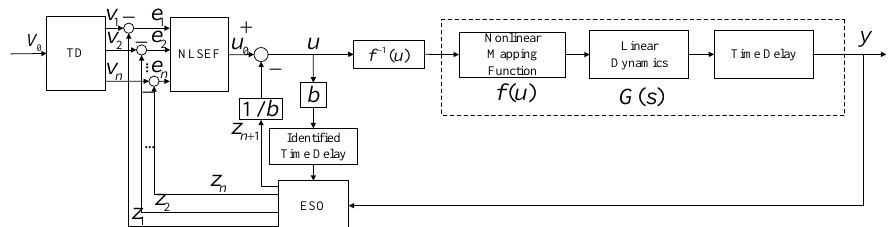
Figure 6. The proposed Hybrid ADRC control